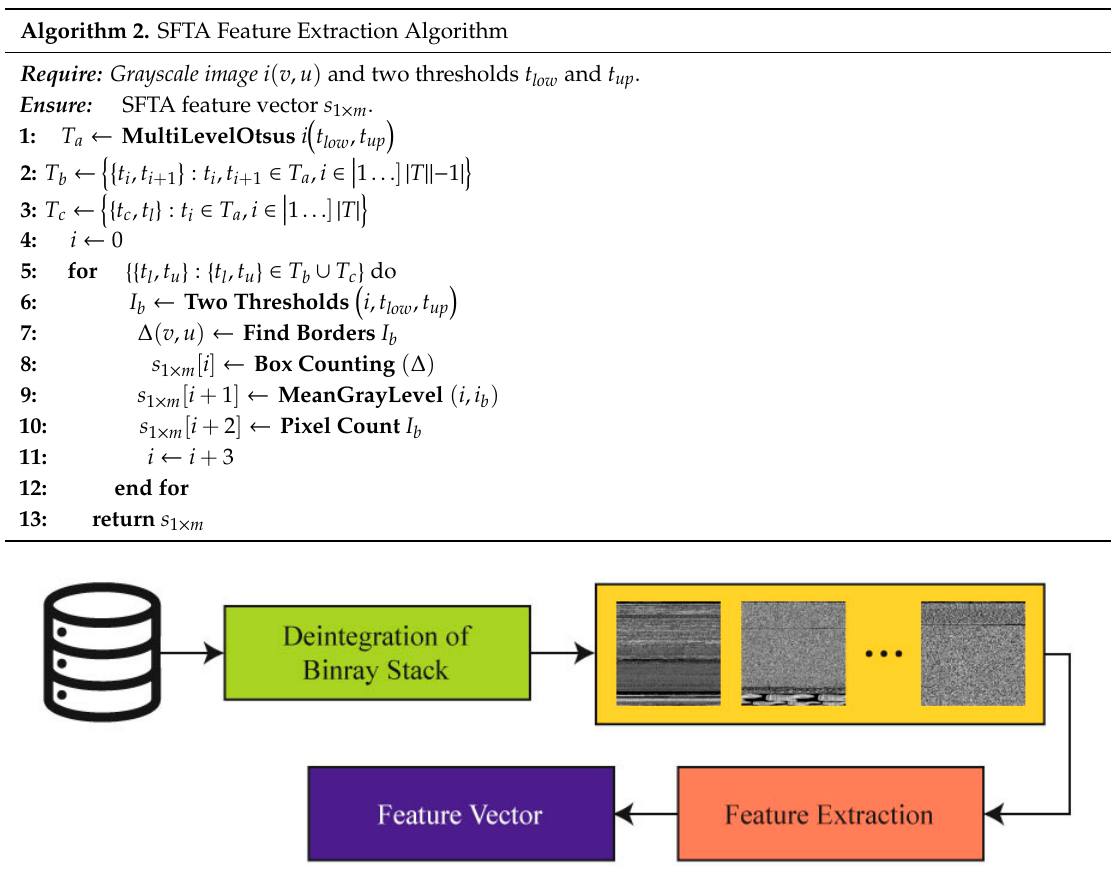
Figure 4. Segmentation-based fractal texture analysis (SFTA) algorithm for the extraction of texture features from malware images. Algorithm 2. SFTA Feature Extraction Algorithm